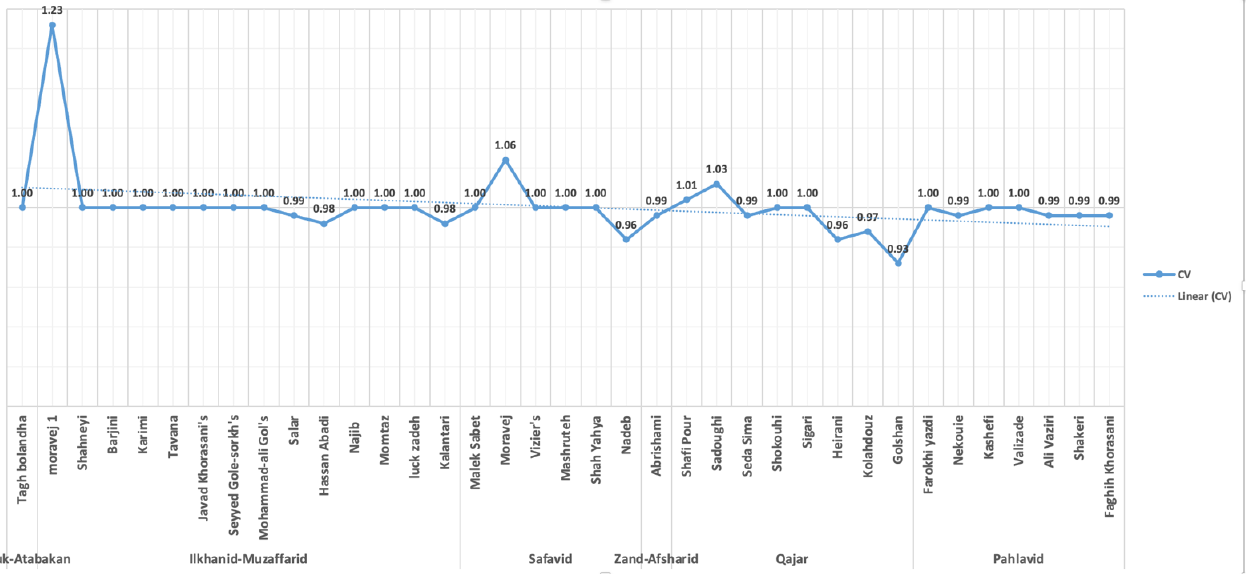
Figure 12. H and H* results and trendlines for the 37 houses, presented chronologically by era. 7. Conclusions Using a variation of the Space Syntax plan graph analysis method, justified by courtyard location, this paper set out to examine three hypotheses about the planning of the Yazd courtyard house. Before reviewing the results, it is important to reiterate two limitations. The method chosen for this paper can only be used to directly comment on the topological properties of the architectural plan, which in turn may have indirect consequences for socio-cultural or climatic interpretations of the function of these houses. Furthermore, the particular software application resulted in some anomalous results and compounded rounding errors, which do occur when dealing with highly connected, matrix-style plans, and cannot easily be resolved. The use of the courtyard as carrier for the graph, while both original and appropriate, was responsible for some of these